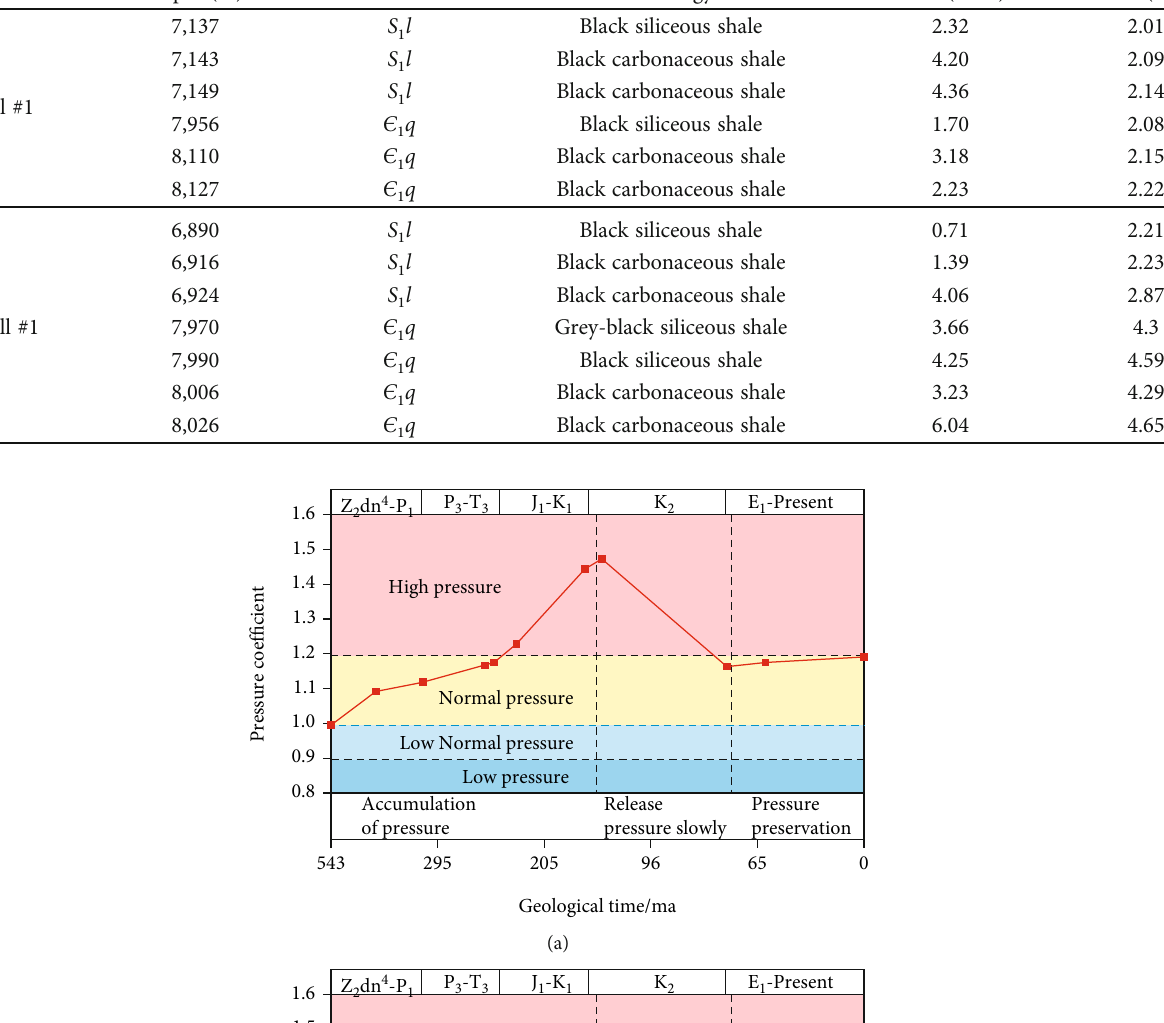
Table 3: Main source rock formation properties of the two wells. TOC: wt.% total organic carbon; Ro: vitrinite re fl ectance. Well